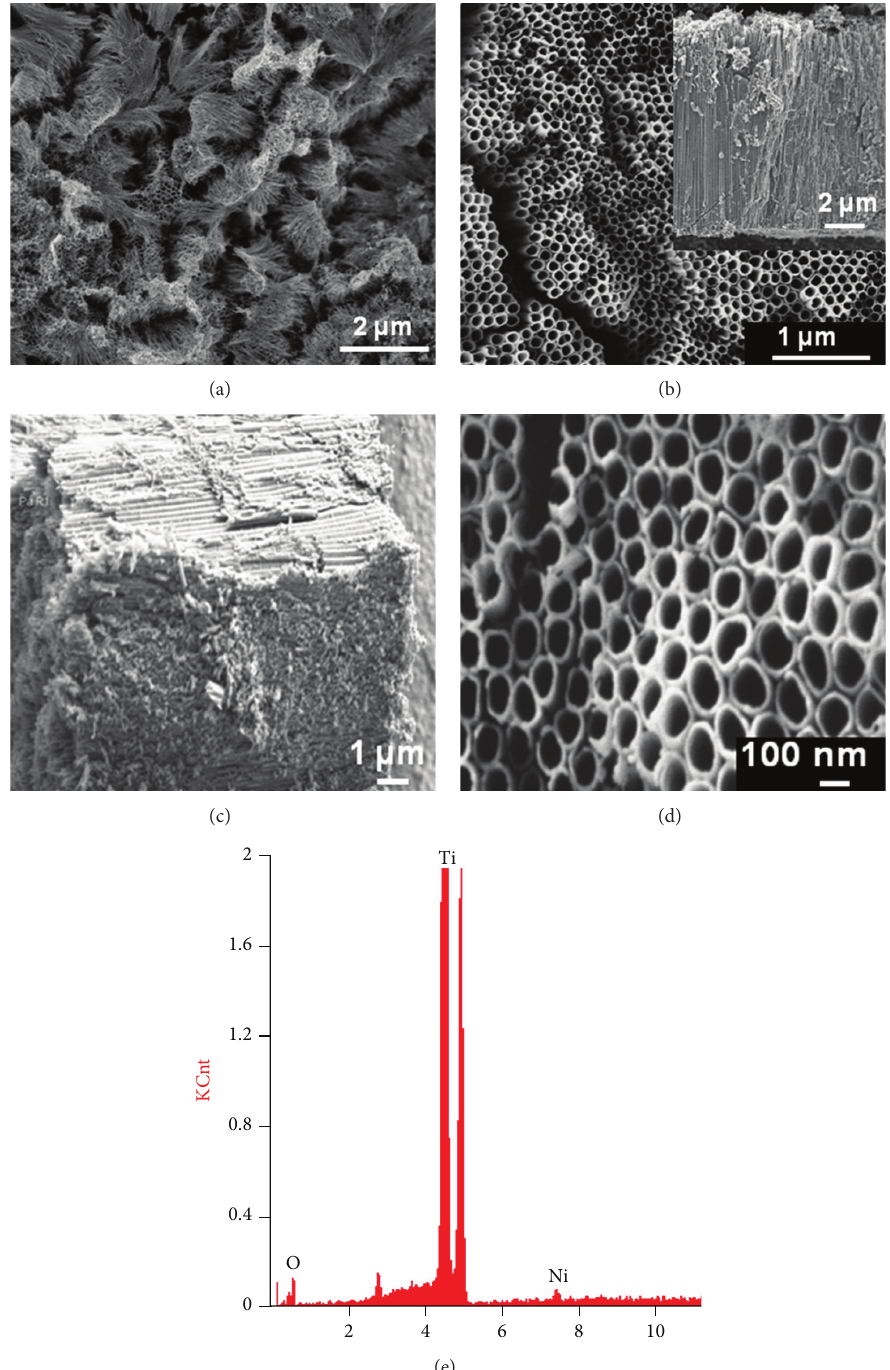
Figure 1: (a) FESEM top-view image of TNTs before ultrasonication; (b) top and cross-sectional (inset) images of TNTs after ultrasonication; (c, d) cross-sectional and top-view images of NiO/TNTs (0.5M); (e) EDX of NiO/TNTs (0.5M).